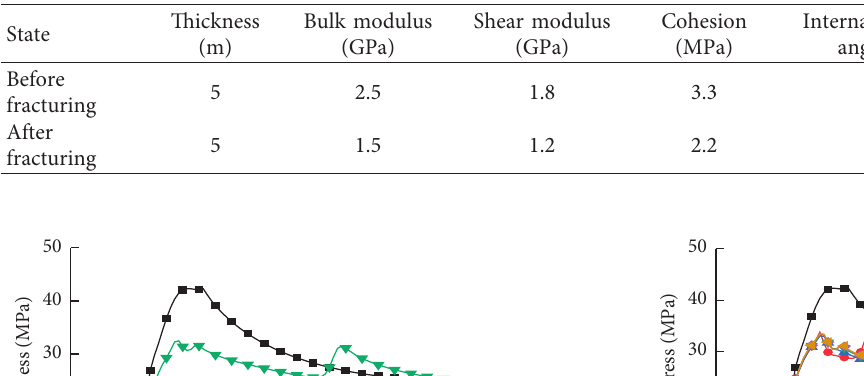
Table 3: Mechanical properties of coal in different states.